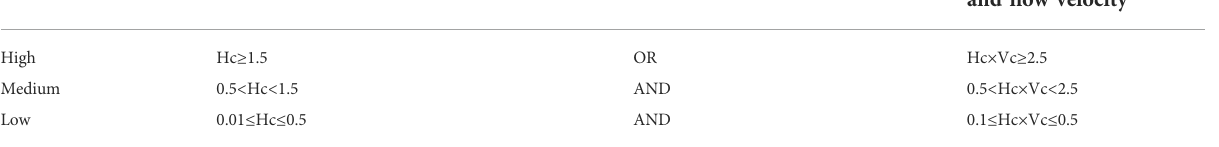
TABLE 3 Standards of debris fl ow hazard zoning.